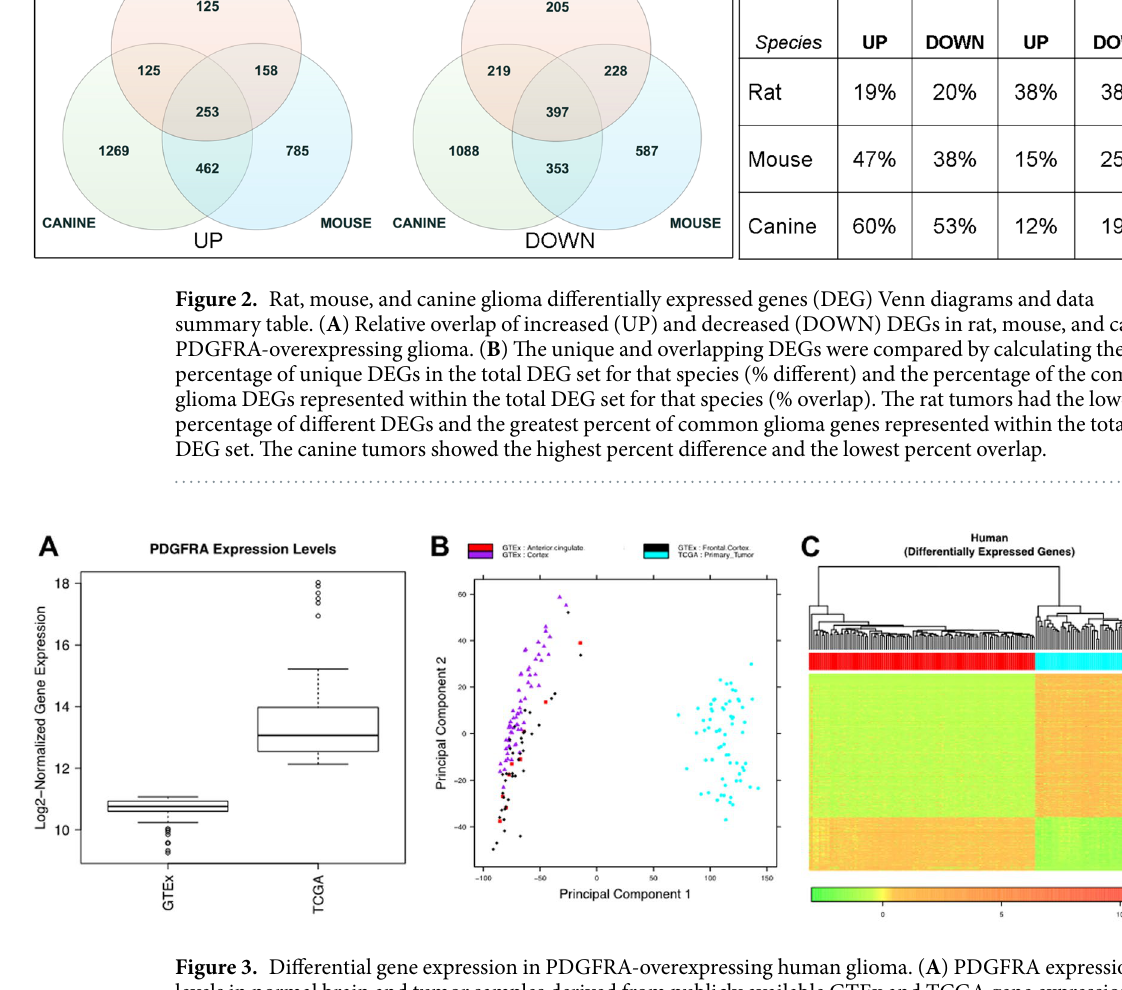
Figure 3. Differential gene expression in PDGFRA-overexpressing human glioma. ( A ) PDGFRA expression levels in normal brain and tumor samples derived from publicly available GTEx and TCGA gene expression data plotted as box and whisker plots. Whiskers of the plot represent the 1.5 IQR of the upper quartile and 1.5 IQR of the lower quartile score (Tukey boxplot) for each expression cluster. Bar in box represents the median value for each group. Top and bottoms of the box represent the 25 th and 75 th percentile, respectively, of the values for each group. ( B ) Principal component analysis demonstrating clustering of normal brain specimens including anterior cingulate tissue (red squares), cerebral cortex tissue (purple triangles), frontal cortex tissue (black diamonds), and brain tumor (blue circles) samples. ( C ) Heatmap representing the degree of variation in gene expression between control, normal human brain tissue (red bar) and human tumor tissue (blue bar). [scale bar: red = increased expression, green = decreased